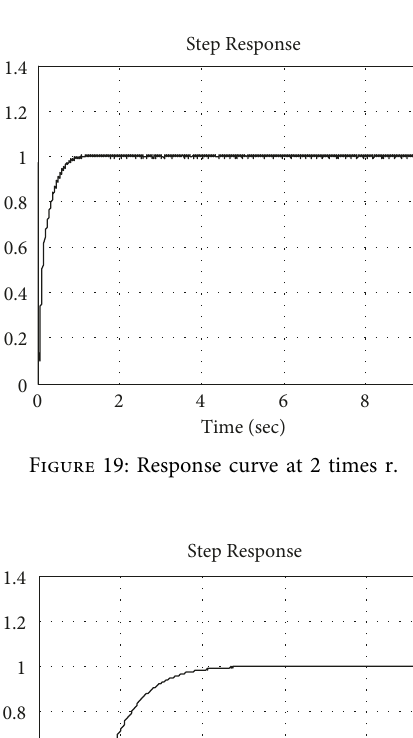
Figure 20: Response curve at 0.1 times r.